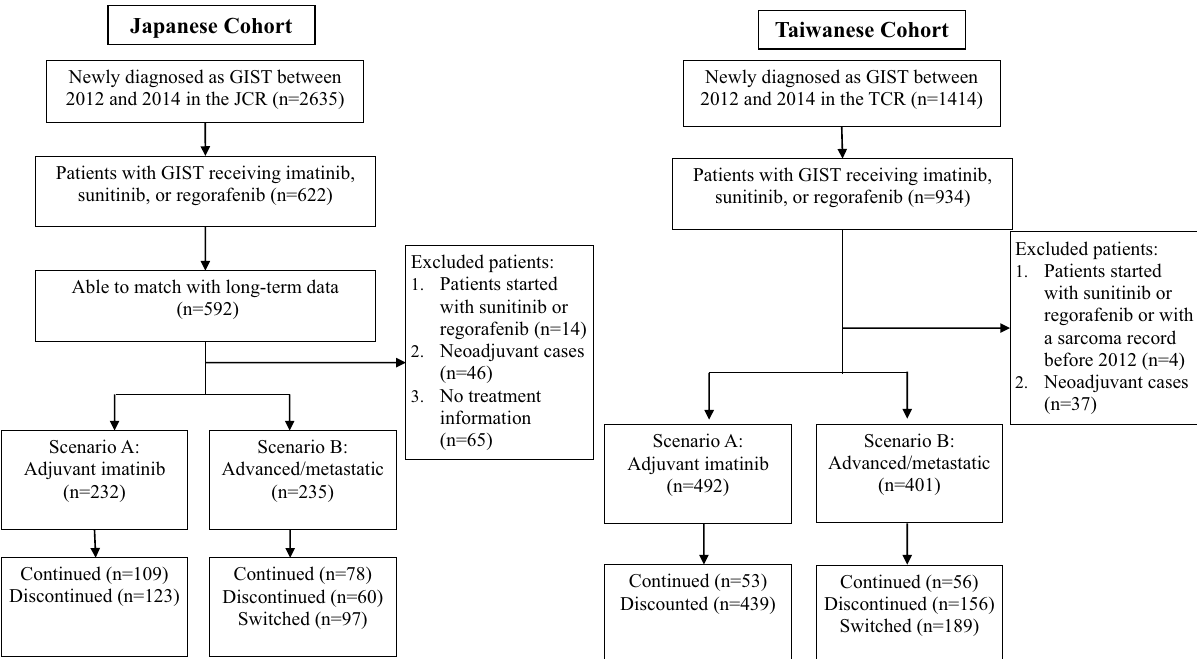
Figure 1. Patient selection flowchart in the JCR and TCR. Details of the patient selection process for each country are explained in the figure. GIST Gastrointestinal stromal tumor, JCR Japanese Cancer Registry, TCR Taiwan Cancer